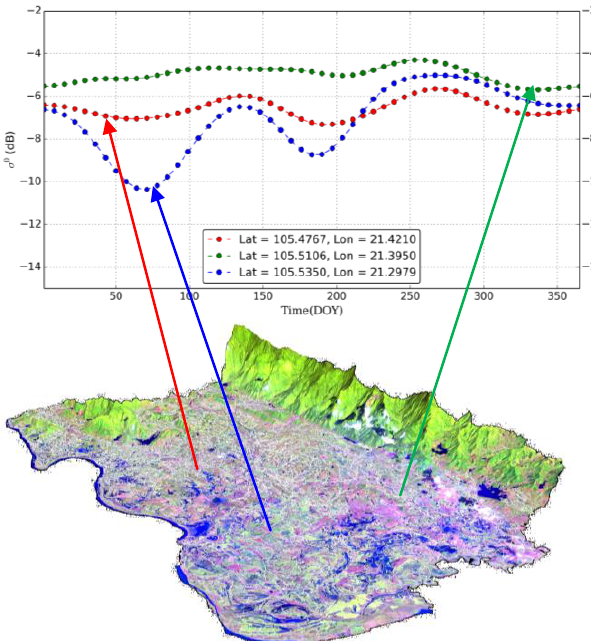
Figure 10. The time series backscatter pattern from Double rice at different location of Vinhphuc province. Red-dot line: Double rice at the open slope areas (wide fields area extend), Green-dot line: Double rice at the complex terrain areas (small fields area extent), Blue-dot line: Double rice at the flat